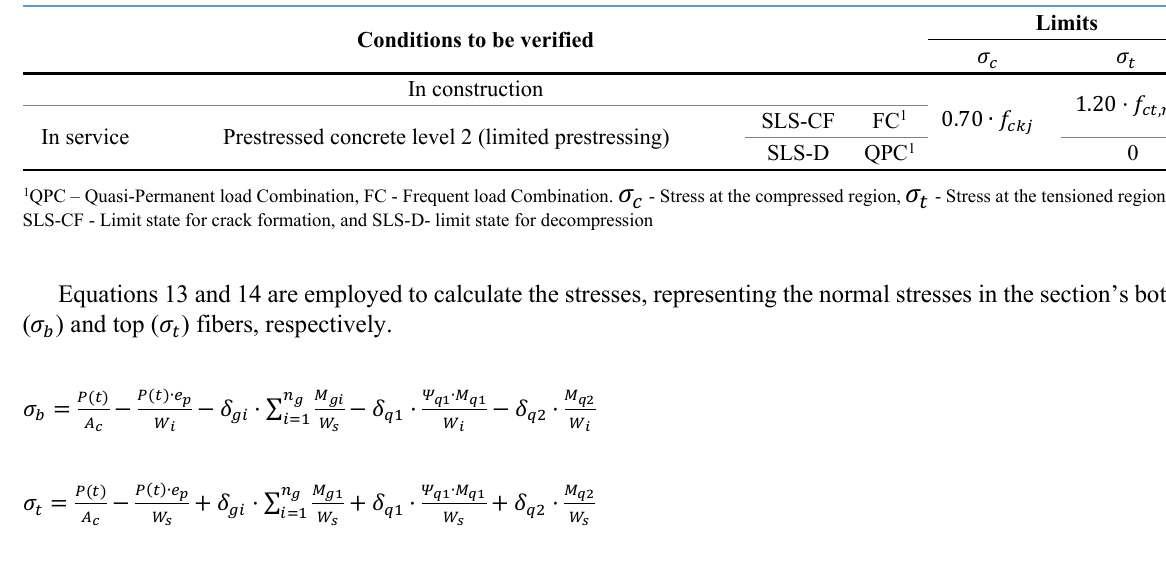
Table 2. Conditions, combinations, and limits for verification of normal stresses